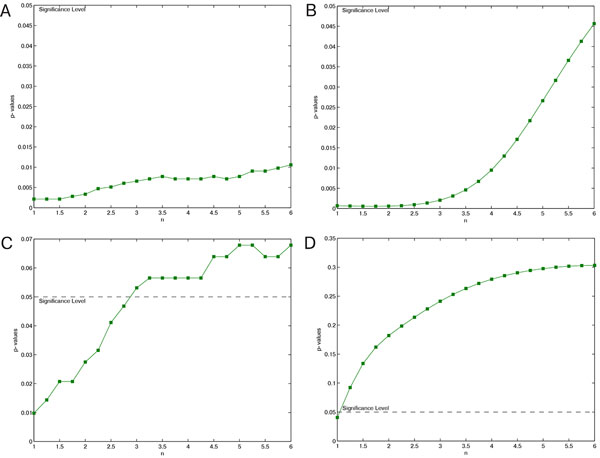
Significance of FuzzyEn for different choices of n. Significance of FuzzyEn for different choices of n for r = rChon (A, C) and r = 0.2σ (B, D); parameters: m = 2, N = 1000, databases: chf2 vs. np (A, B) and mit vs. np (C, D)